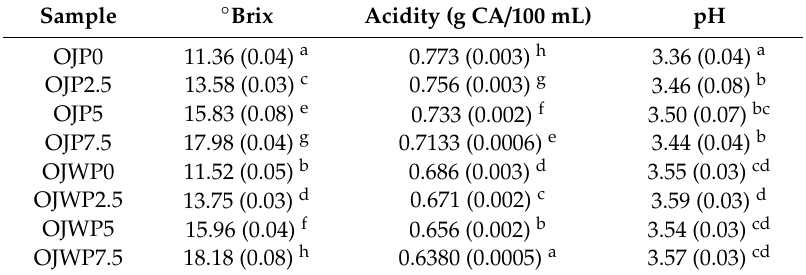
Table 1. Mean values (and standard deviations) of ◦ Brix, pH, and acidity of pasteurised orange juice. Sample ◦ Brix Acidity (g CA / 100